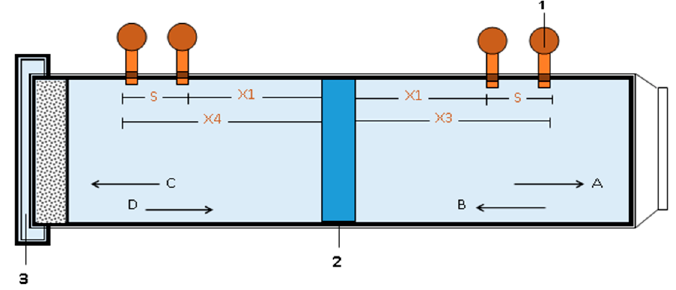
Figure 2. A section of the impedance tube with four microphones, as used in the sound transmission loss test.